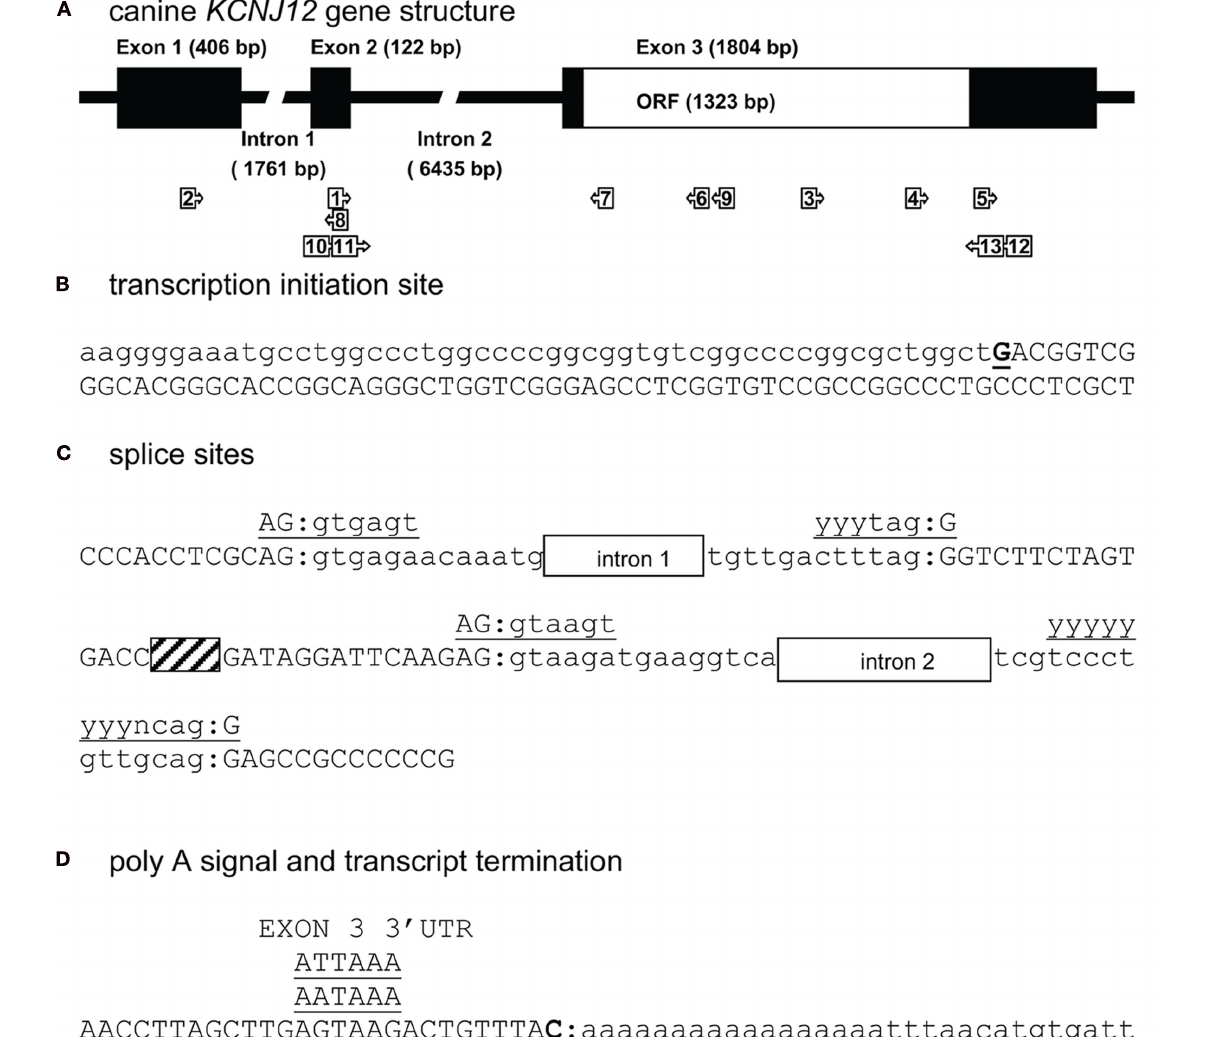
FIGURE 2 | Canine KCNJ12 genomic structure. (A) Representation of the KCNJ12 gene indicating lengths of first, second, and third exons, first and second intron, and the open reading frame (ORF). Relative position of KCNJ12 specific primers used for intron/exon mapping, 5 (cid:2) and 3 (cid:2) RACE are indicated by numbered box arrows 1–9. Relative positions of KCNJ12 specific primers for cloning the ORF are indicated by numbered box arrows 10–13. (B) Transcription initiation site (bold and underlined) with upstream (lower case) and downstream exon 1 (upper case) sequences. (C) Sequence surrounding